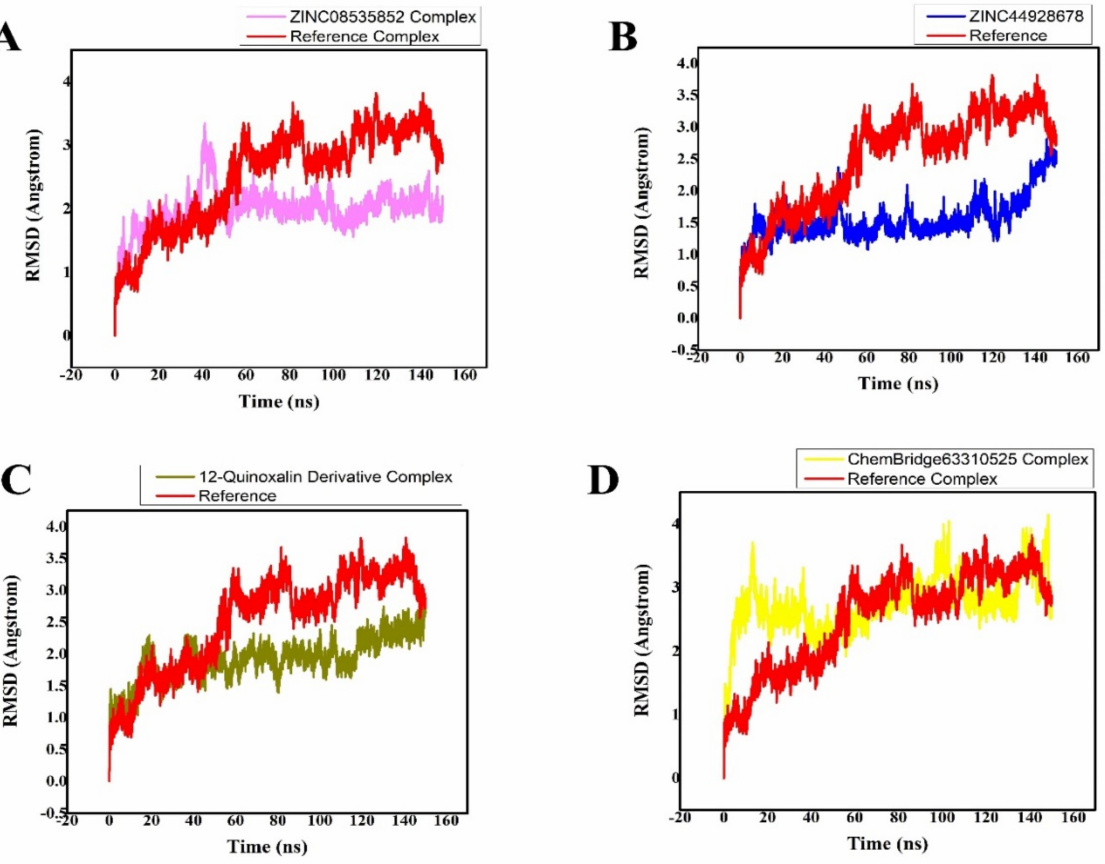
Figure 6. ( A – D ) Plot of the lead hits/M pro and ref-ligand (N3)/M pro complexes’ root mean square